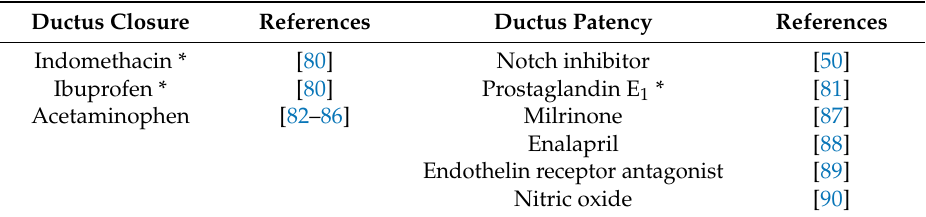
Table 3. Clinical and experimental agents for management of ductus